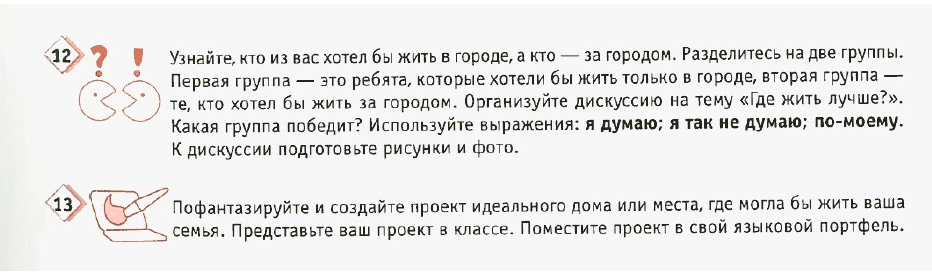
Figure 3. Example 1 of a task in Russkiy klass .